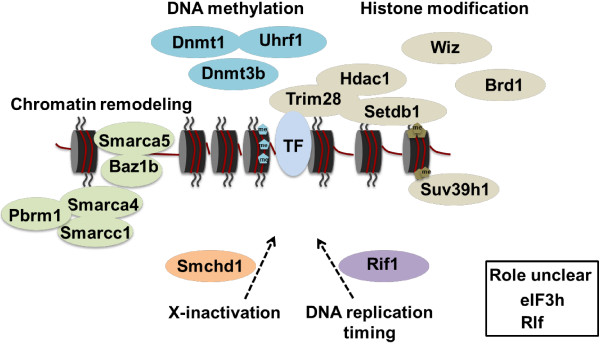
MommeD genes involved in transgene silencing in the mouse. Using an ENU mutagenesis screen, 18 unique genes were identified to be involved in transgene silencing in the mouse. Factors are grouped by their broad mechanistic role in epigenetic regulation. TF, transcription factor; Me, methyl. Figure adapted from [2].